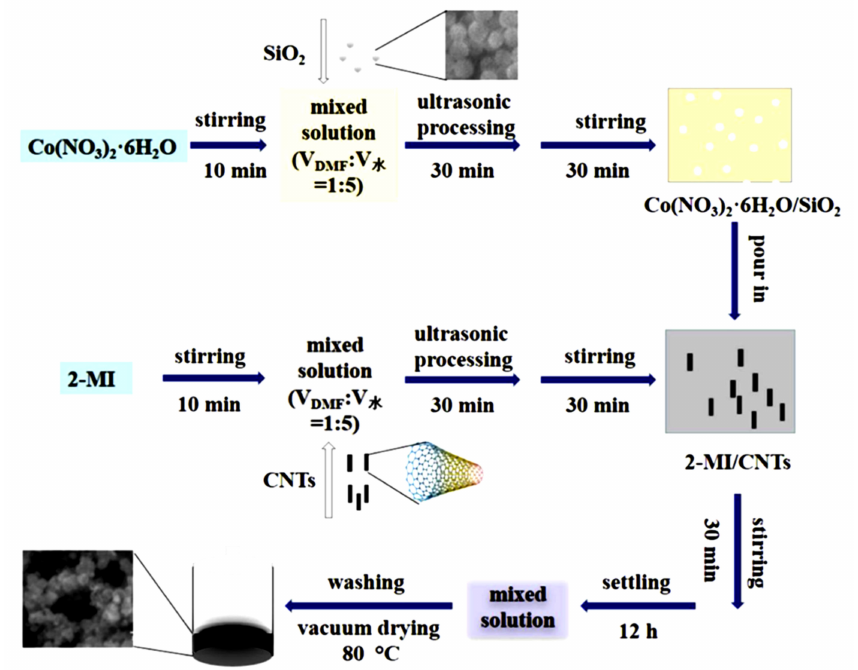
Figure 23. SiO 2 @ZIF-67-CNTs preparation process. Reprinted with permission from